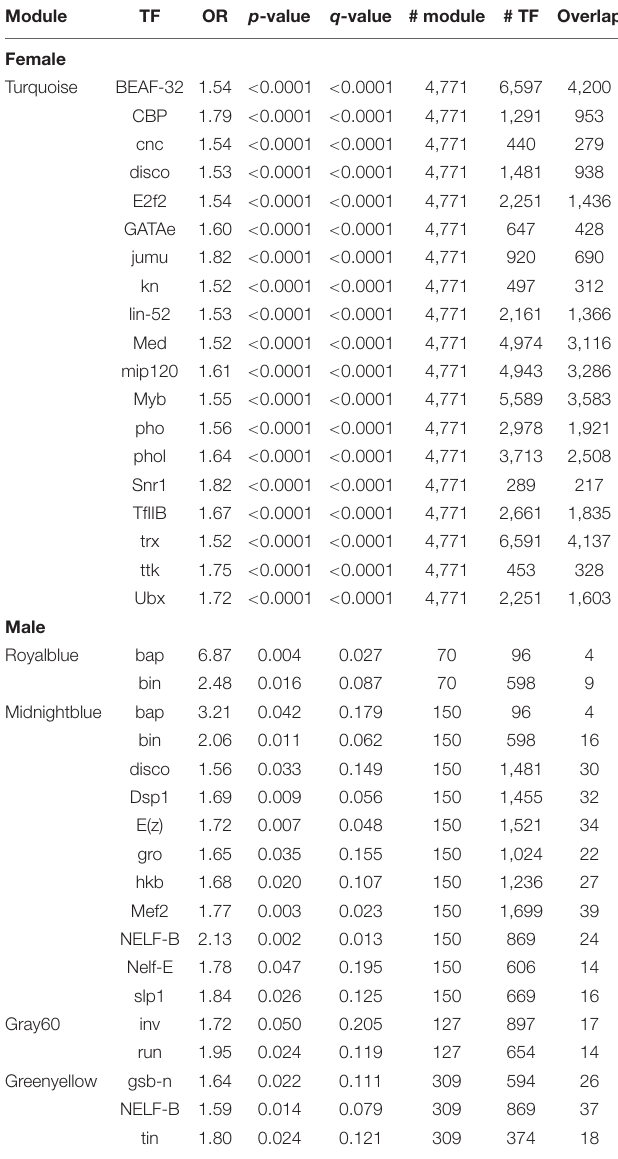
TABLE 2 | Transcription-factor binding enrichments per